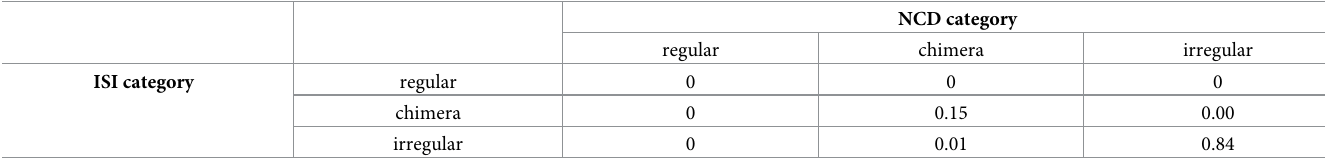
Comparison of categorization with ISI statistics and NCD using 35,000 Baraba´si-Albert network states. 100 networks were generated for each m = 2, 3, ... , 8, and 50 states were produced from each network with different random initial conditions. The overall agreement calculated as the sum of the diagonal over the total sum is